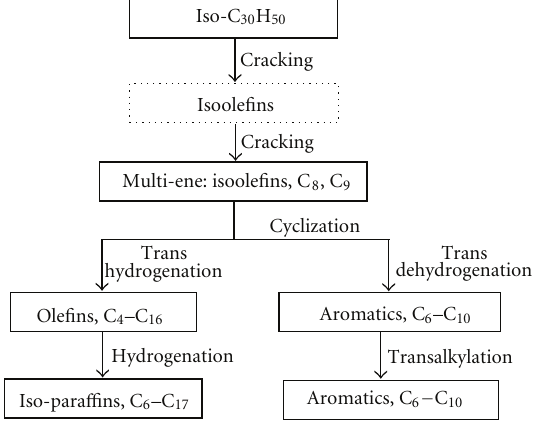
Figure 6: Reaction Scheme of Catalytic Cracking and Hydrocrack- ing of Nonhydrotreated Oil Based on Figures 2 and 5.